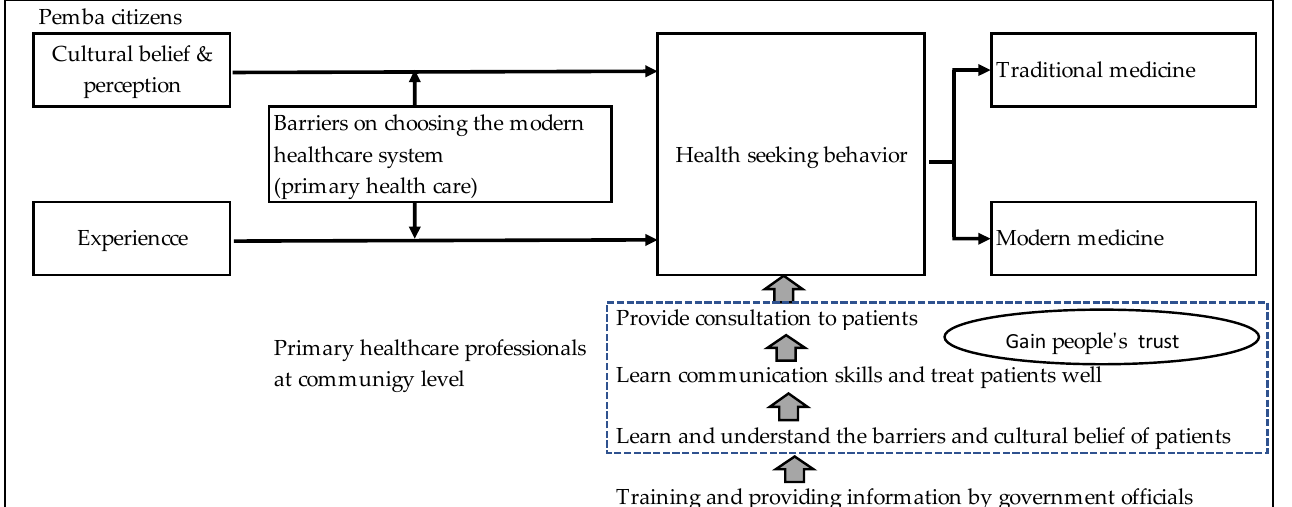
Figure 1. Conceptual framework.